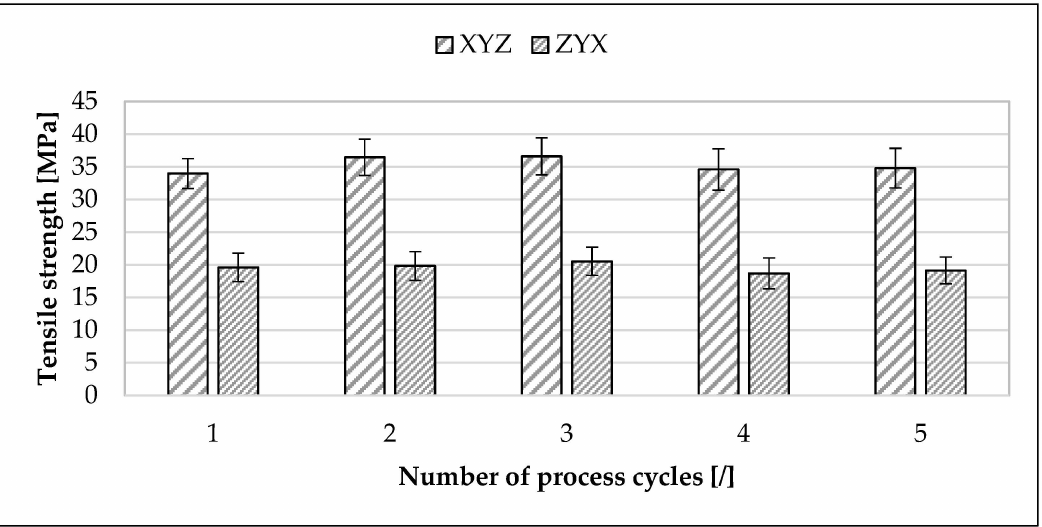
Figure 12. Influence of cyclic reuse on tensile strength of the specimens manufactured from the used polyamide 12 sinter material. Five process cycles were considered. XYZ- and ZYX-specimens were analyzed. The refresh rate was 30 wt%.